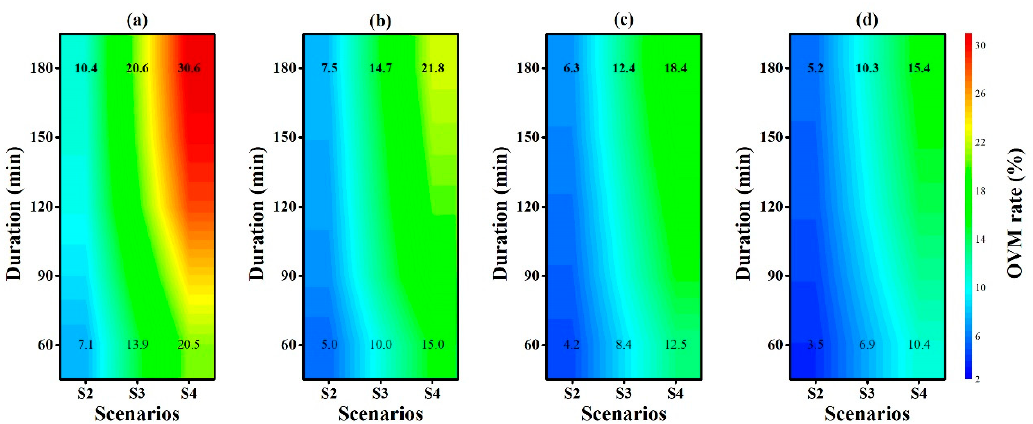
Figure 9. Overflow volume mitigation (OVM) across three design scenarios (S2, S3, and S4) compared to current conditions (S1) during ( a ) 2-, ( b ) 5-, ( c ) 10-, and ( d ) 20-year rainstorm return periods (RP) of different durations.